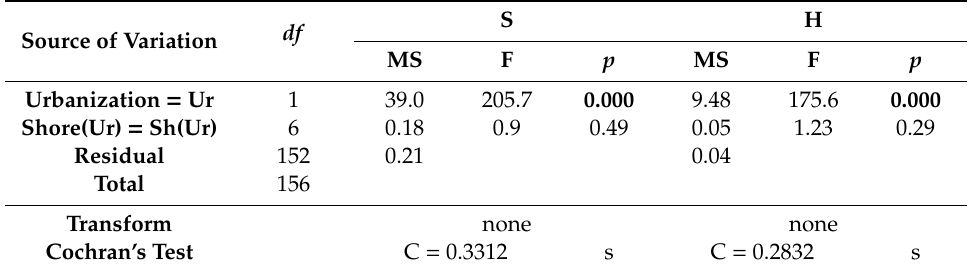
Table 1. Results of ANOVAs testing for di ff erences in the total number of taxa (S) and Shannon’s diversity index (H’) on canopy assemblages from urban and non-urban shores. Significant e ff ects are indicated in bold. s: significant.